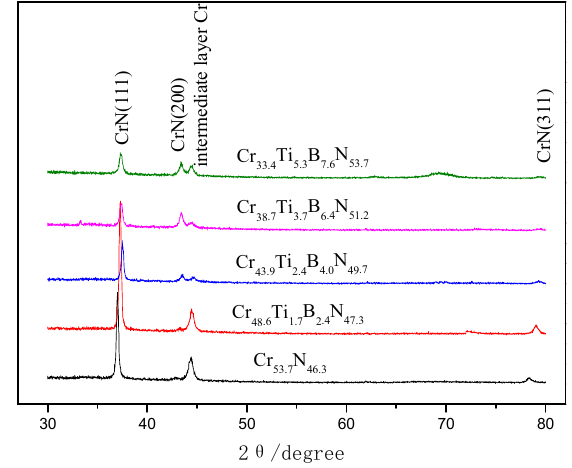
Figure 1. X ‐ ray diffraction patterns of Cr ‐ Ti ‐ B ‐ N films. Figure 1. X-ray diffraction patterns of Cr-Ti-B-N